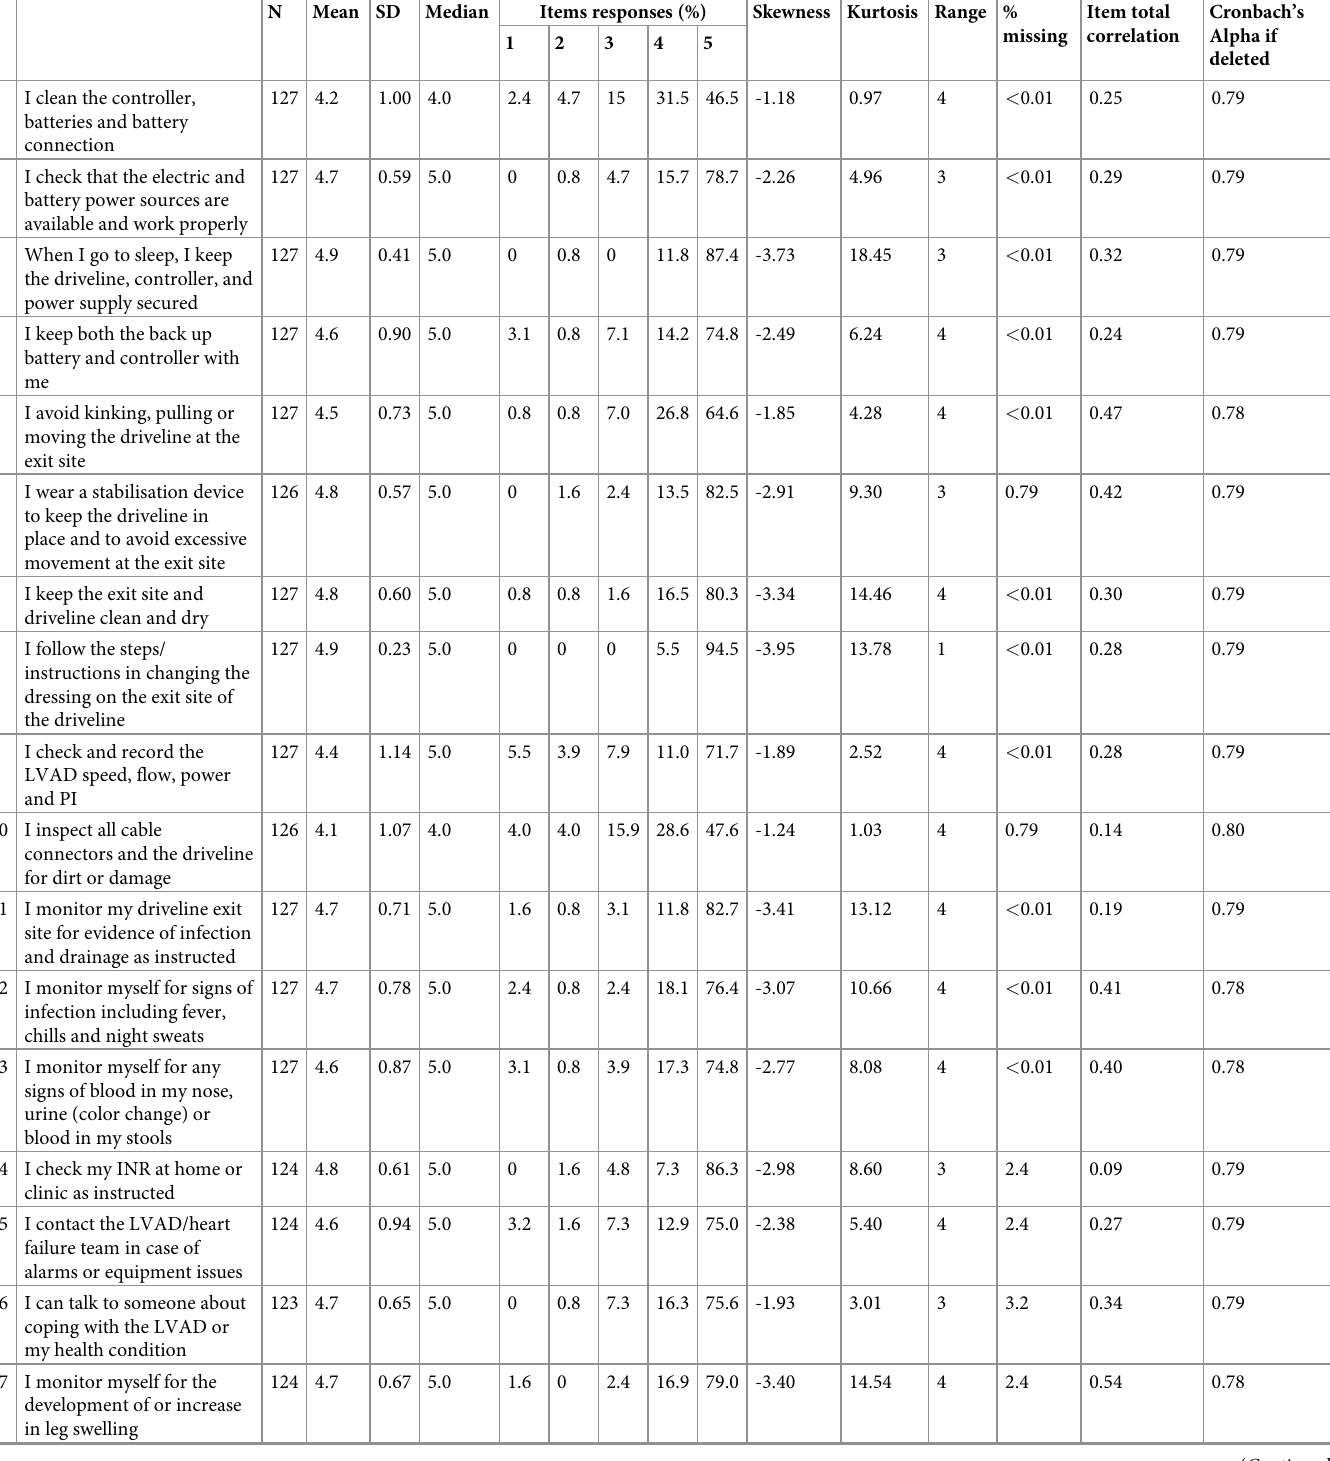
Table 2. Descriptive statistics of the 33 items of the LVAD self-care